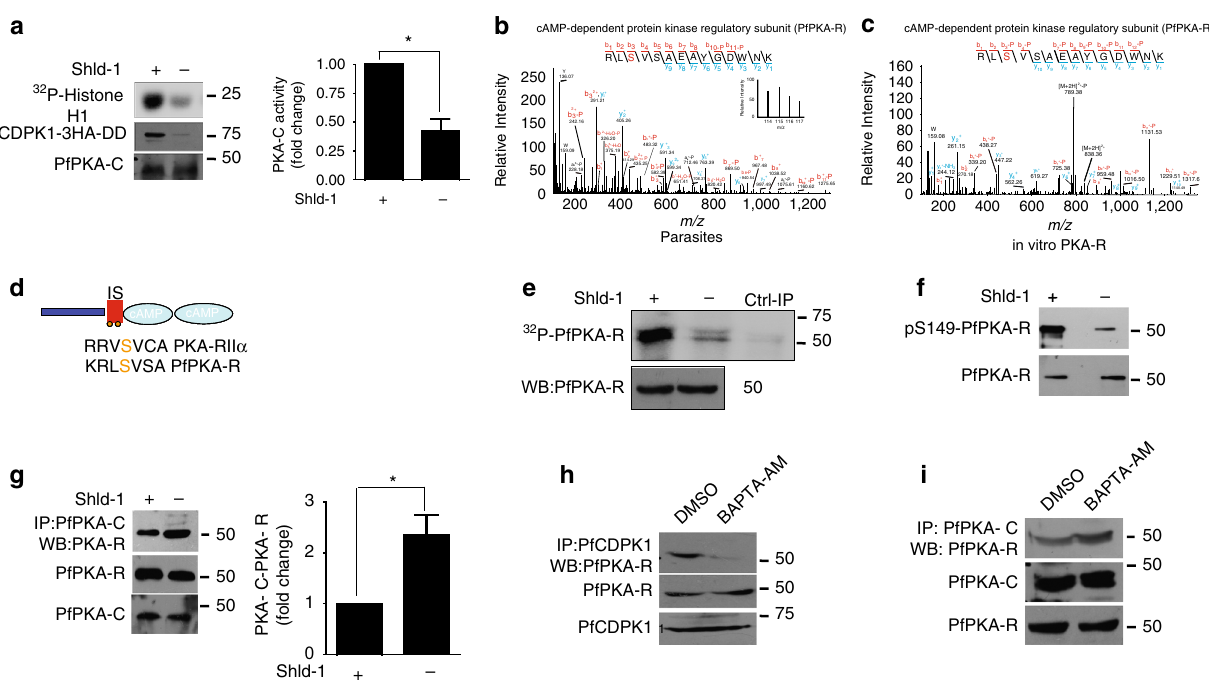
(Fig. 3e). An antibody against the S149-phosphorylated form of